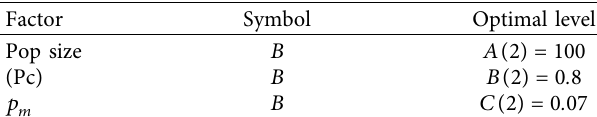
Table 5: Optimum levels of GA parameters in large size